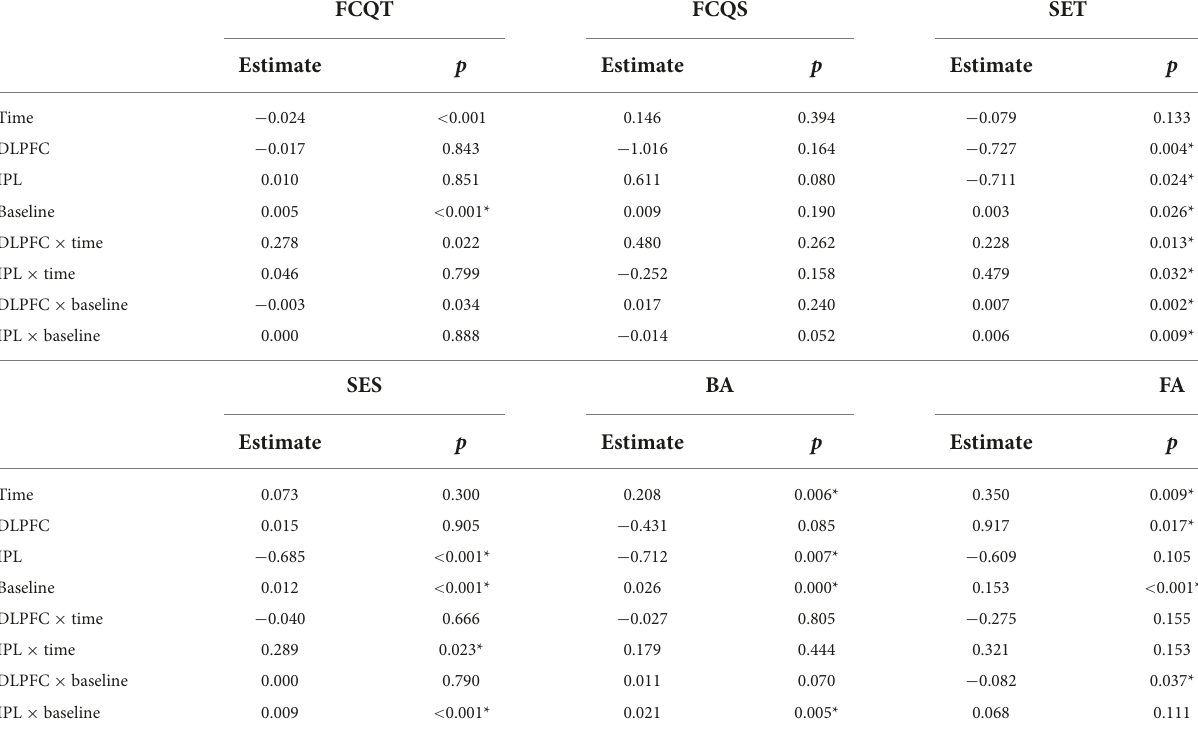
TABLE 3 Results of the general estimating